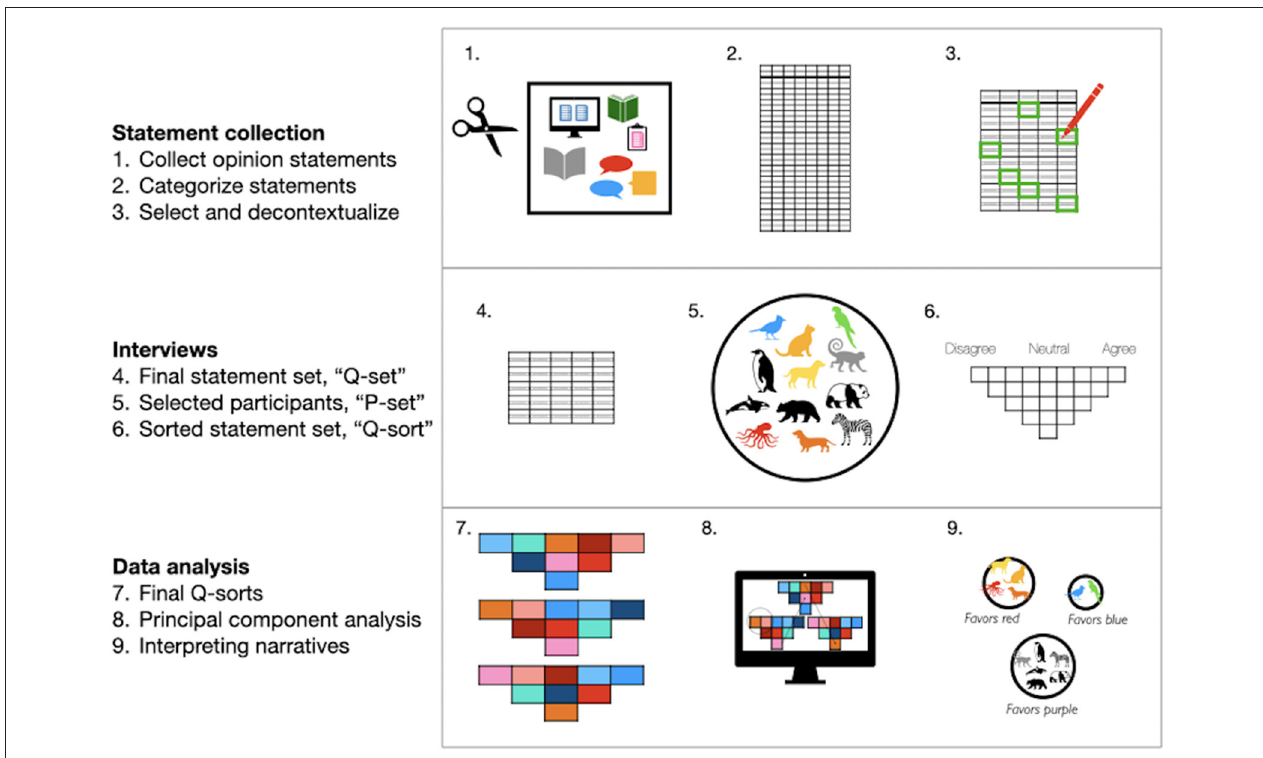
FIGURE 1 | Nine steps in Q-methodology include the creation of a statement set, interviews, and data analysis to interpret the narratives. This graphic was used to explain the process to the interviewees.